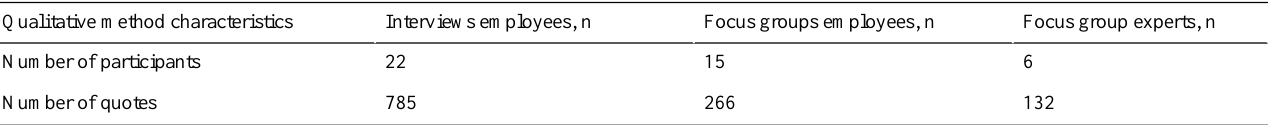
Table 2. Number of participants in interviews and focus groups and number of quotes that were yielded with three different qualitative